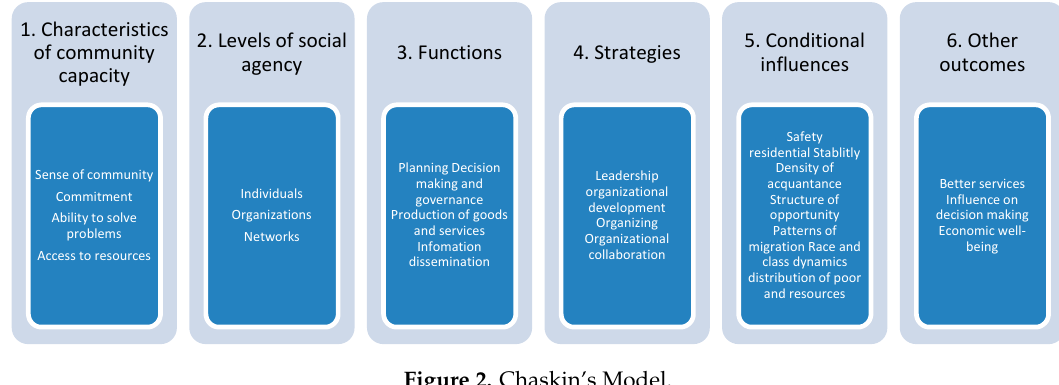
Figure 2. Chaskin’s Model.